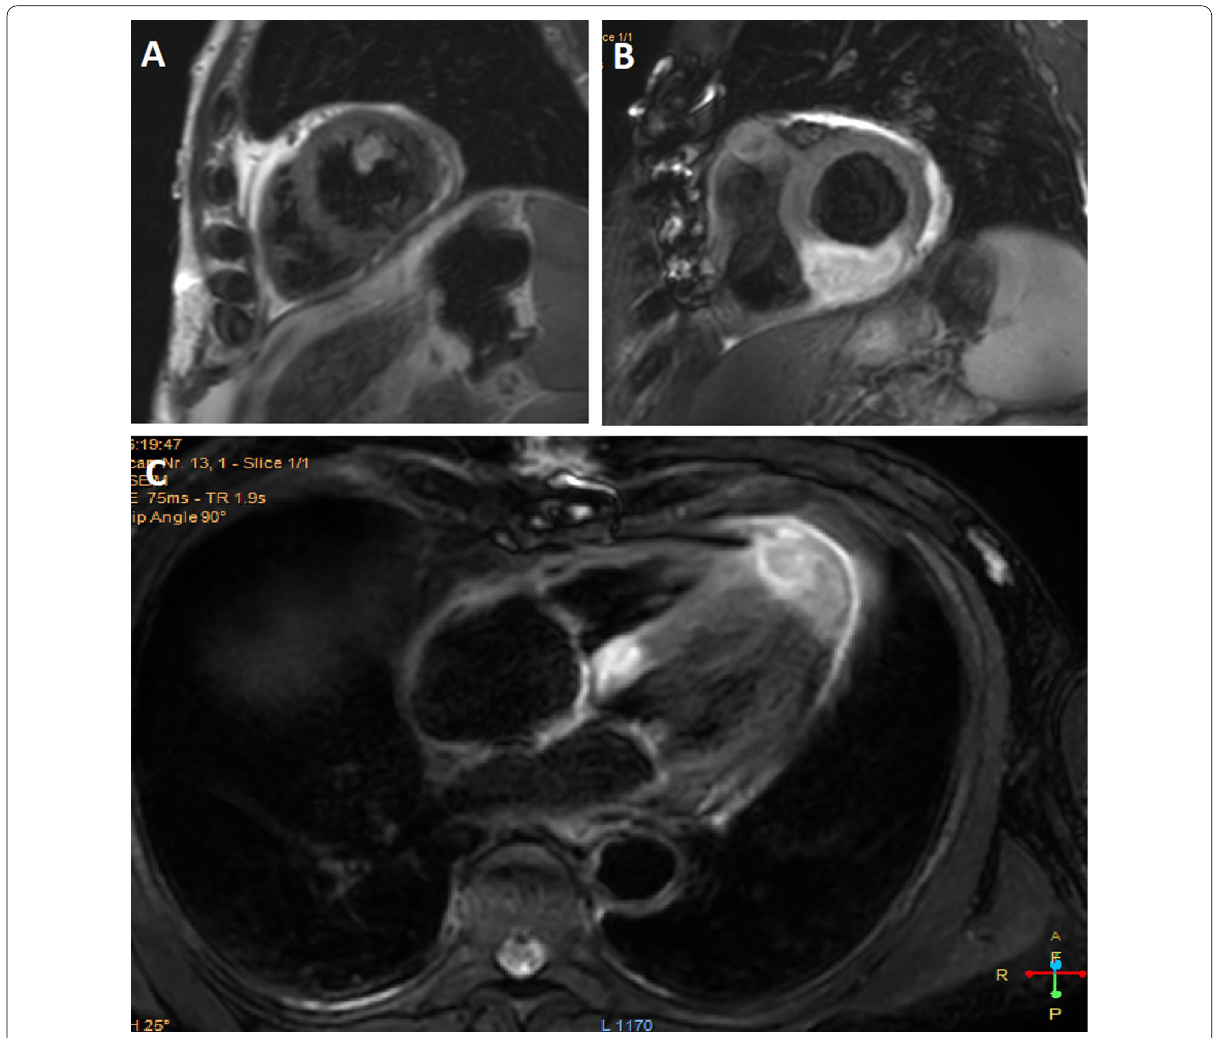
Fig. 5 Cardiac Magnetic Resonance Imaging: T2-weighted images in short axis views ( A , B ) and 4-chamber view ( C ), identifying three hyperintense lesions (high fluid content), including an anteromedial papillary muscle lesion ( A